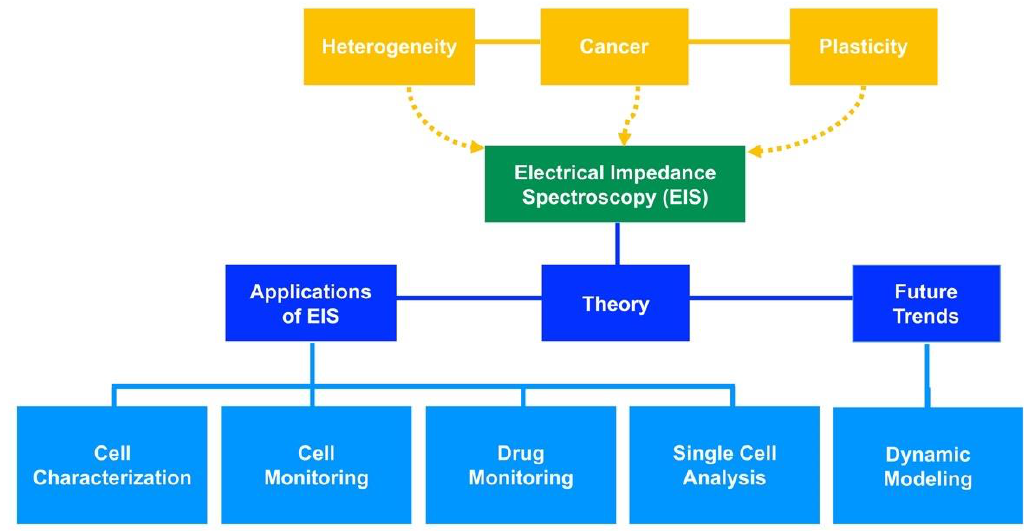
Figure 1. Overview of the main topics covered in this review.